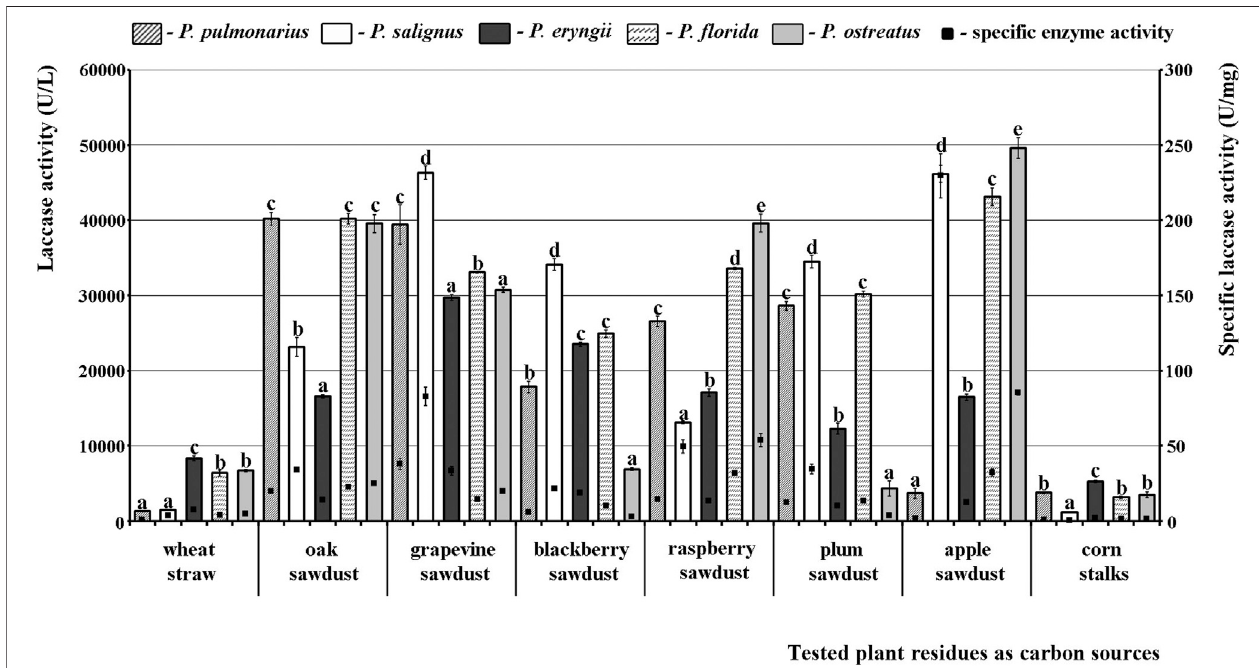
FIGURE 3 | Activity of laccases of Pleurotus spp. depending on the type of agro-forestry residues. Values superscripted with the same letter in each values group (for each plant residue) are not signi fi cantly different ( p <